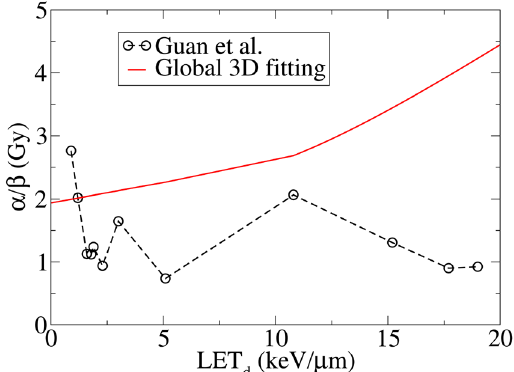
Figure 9. Lack of correlation among LETs in fitted cell-survival data in the conventional fitting procedure leads to strong fluctuations in α / β as reported by Guan et al . 32 . In contrast, α / β increases with increasing LET d in 3D global fitting consistent with the cell inactivation target theory (H460